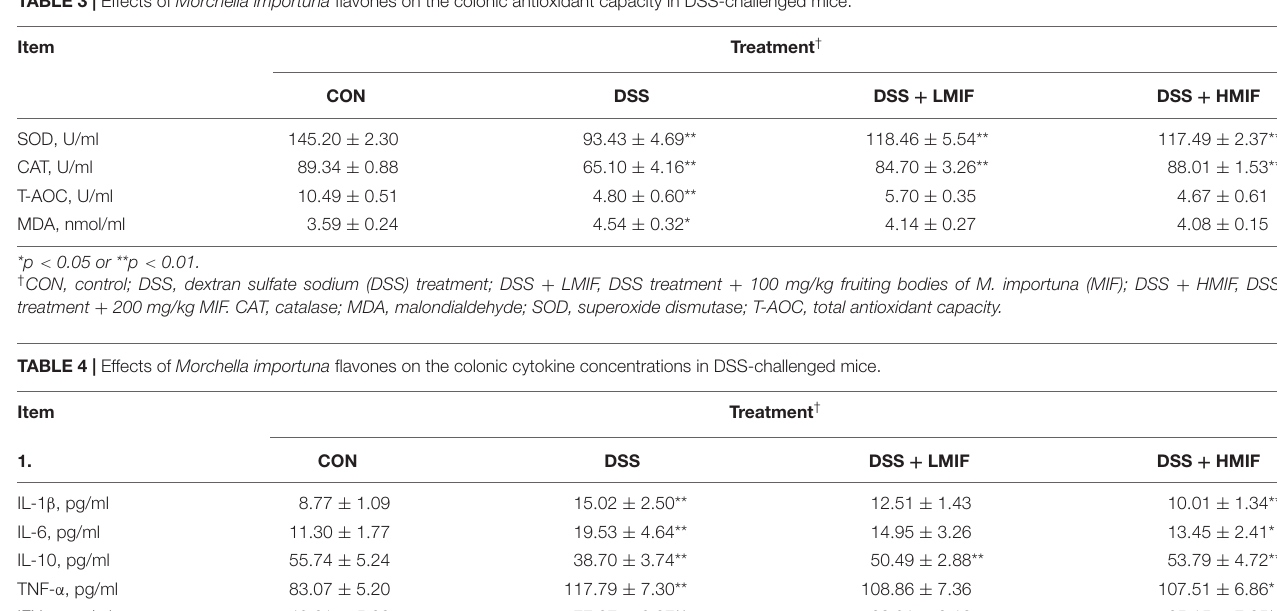
TABLE 3 | Effects of Morchella importuna flavones on the colonic antioxidant capacity in DSS-challenged mice.